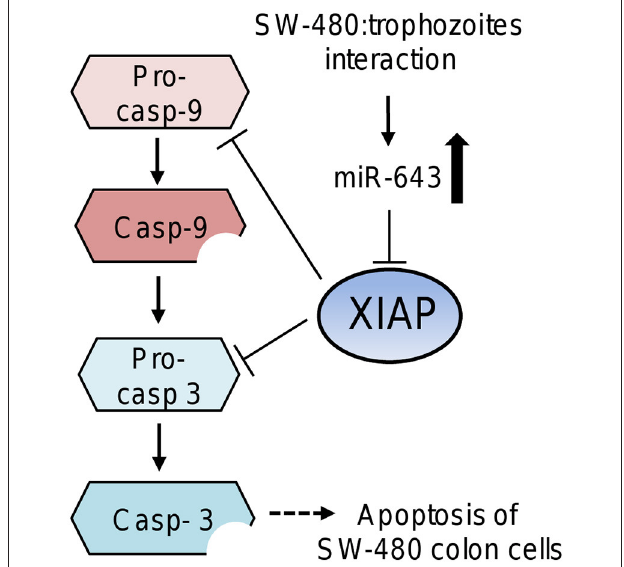
FIGURE 6 | Working model that describes the possible participation of miR-643 in apoptosis of SW-480 cells driven by E. histolytica . Upregulation of miR-643 occurs after contact of SW-480 cells with parasites. Then miR-643 may target the XIAP 3 ′ UTR inducing the downregulation of XIAP protein levels, which release the inhibition of caspase-3 and -9. In consequence the executioner caspase-3 triggers degradation of cellular proteins inducing the apoptosis of SW-480